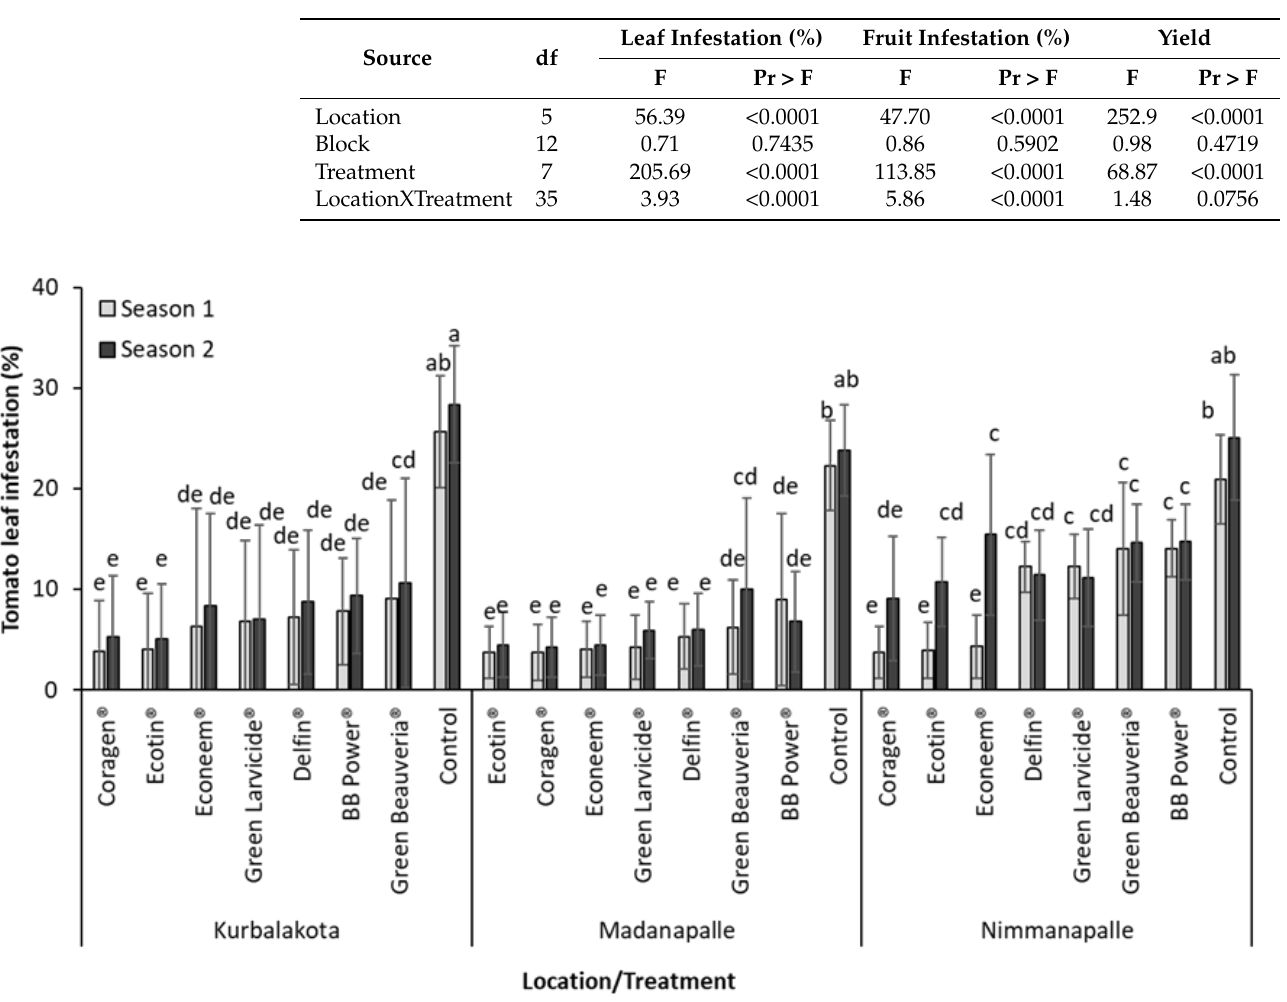
Figure 1. Mean ( ± SE) tomato leaf infestation percentage in three different locations of Andhra Pradesh, India and the following two growing seasons: season one: May – August 2018; season two: September – December 2018. Means represent average of ten replications for each treatment and three blocks ( n = 30). Beauveria bassiana -based formulations are as follows: Green Beauveria ® and BB Power ® ; Bacillus thuringiensis -based formulations are as follows: Green Larvicide ® and Delfin ® ; neem-based formulations are as follows: Econeem ® and Ecotin ® ; chemical pesticide is the following: Coragen ® . Mean(s) followed by same letter(s) are not significantly different based on Tukey’s HSD ( p =